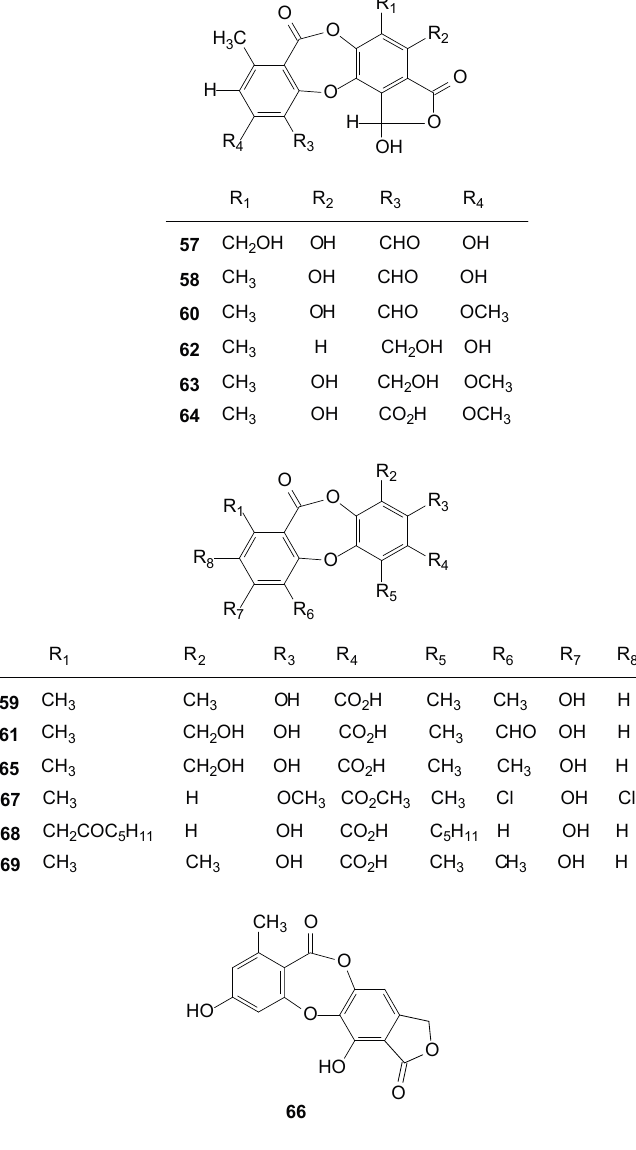
Figure 4. Chemical structures of depsidones from Ramalina species of lichenized fungi.